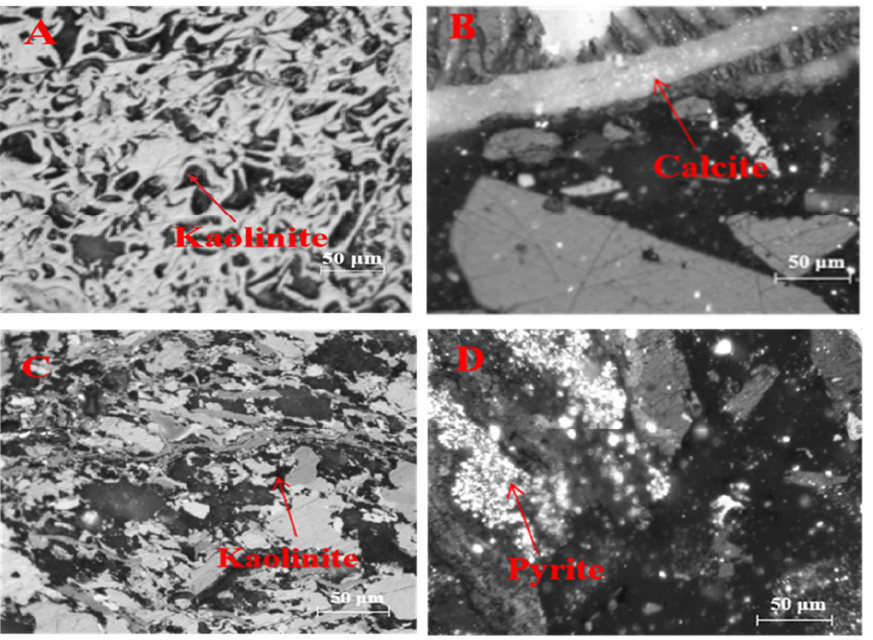
Figure 4. The minerals in the coal samples: ( A ) kaolinite; ( B ) calcite; ( C ) kaolinite; ( D ) pyrite (under reflected light).